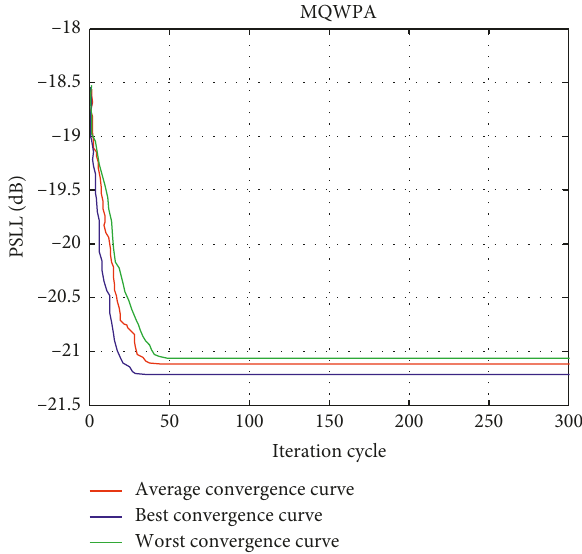
Figure 10: Convergence curve of fitness function. MQWPA for Example 2